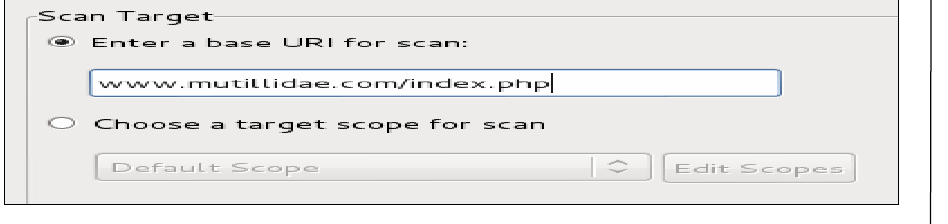
Figure 14 – Vega – entry of the targeted URL Рис . 14 – Vega – ввод целевого URL